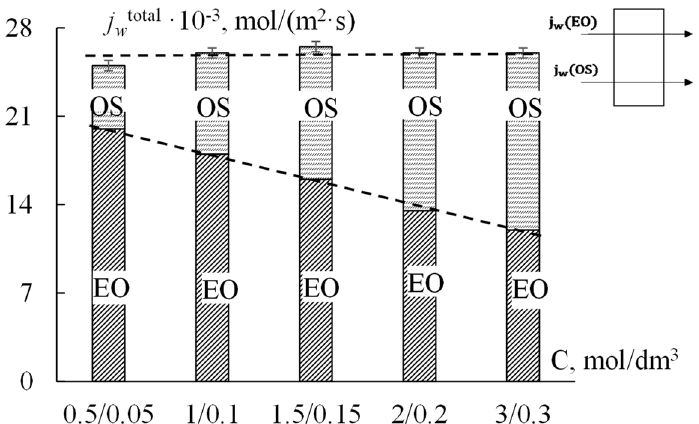
Figure 2. The total water flux through the MF − 4SC membrane in NaCl solutions with the concentration ratio C 10 / C 20 = 10: OS and EO are the contributions of osmotic and electroosmotic mechanisms of water transport, respectively.